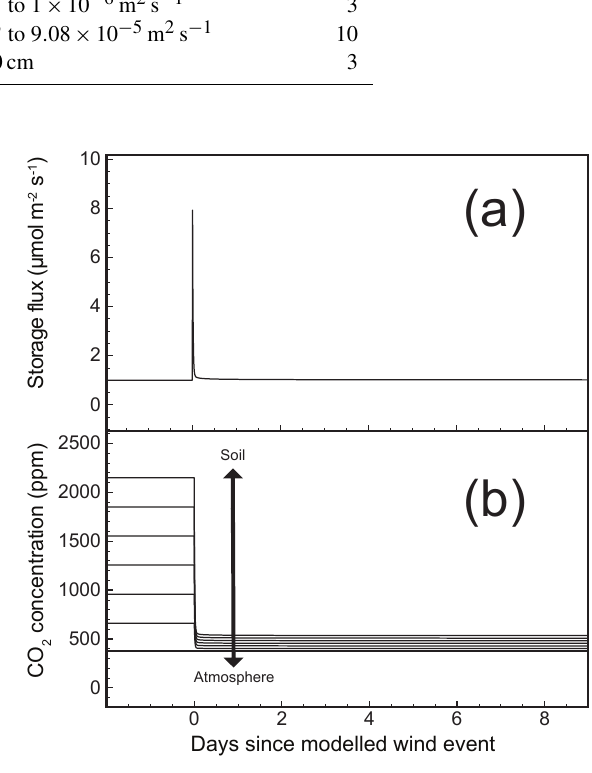
Figure 2. An instantaneous change in snowpack diffusivity after model initialization mimics advection. Panel (a) shows the mod- elled storage flux with an induced change in snowpack CO 2 diffu- sivity. Panel (b) shows the corresponding change in snowpack CO 2 concentration at every 10cm. Soil diffusivity is 1 . 00 × 10 − 7 m 2 s − 1 , stepped snow diffusivity is 9 . 08 × 10 − 5 m 2 s − 1 , and snow depth is 60cm. The soil–atmosphere arrow indicates depths within the 60cm snowpack: highest modelled CO 2 concentrations occur at the soil–snow interface, whereas lowest modelled CO 2 concentrations occur at the snow–atmosphere interface, before and after the advec- tive “wind